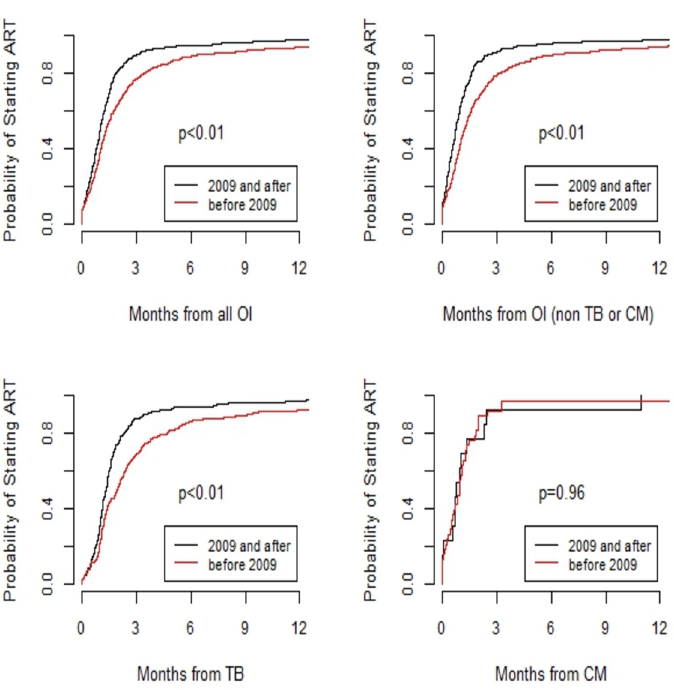
Fig 2. Probability of starting HAART after all opportunistic infections (A); opportunistic infections excluding tuberculosis and cryptoccocal meningitis (B); tuberculosis (C) or cryptococcal meningitis (D), before and after